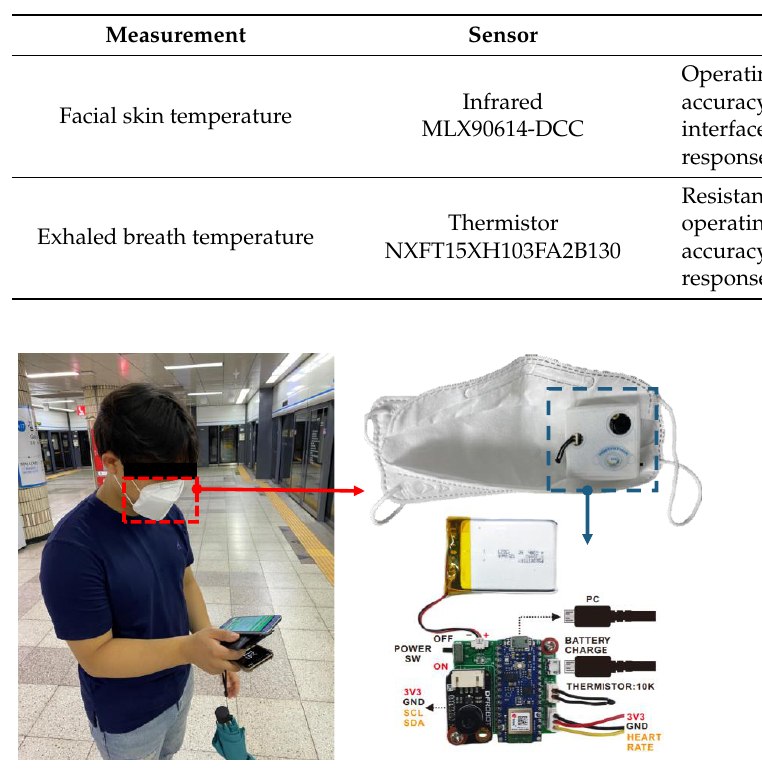
Figure 1. Details of the developed smart face mask with the embedded sensors.